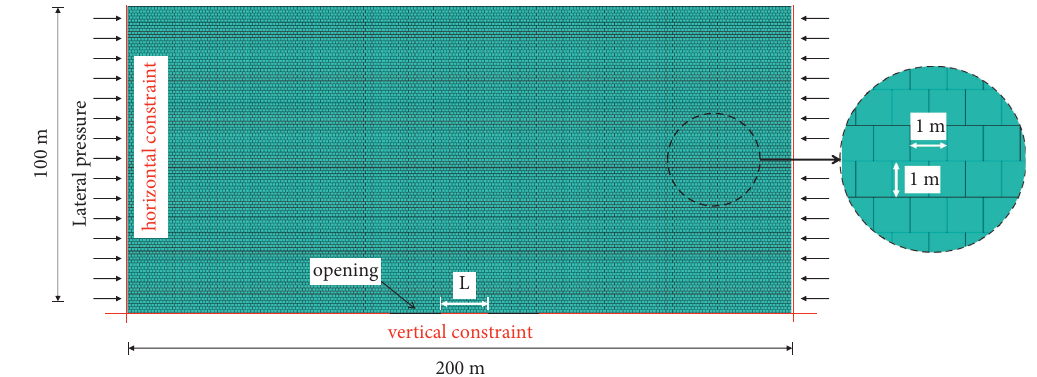
Figure 1: Numerical models used in the simulation. Table 1: Design of the numerical